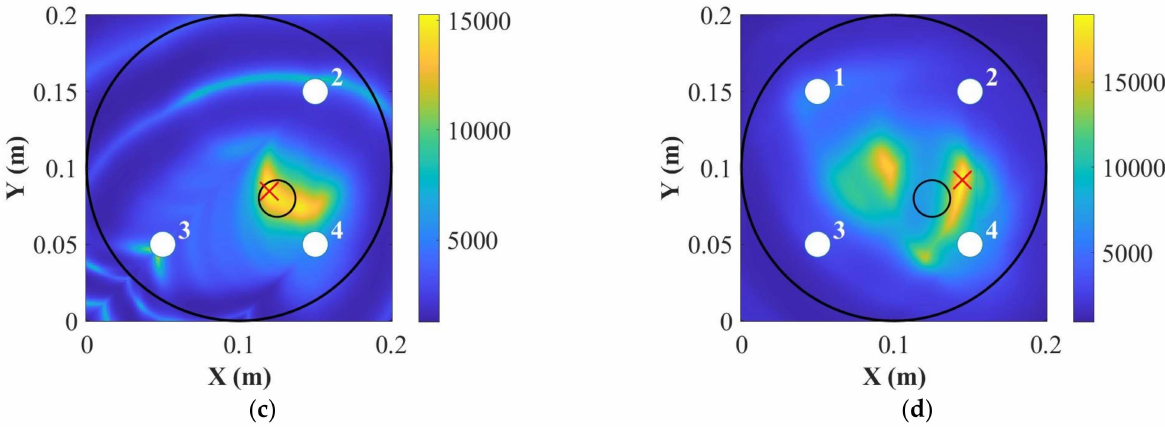
Figure 10. Detection of surface-mounted artificial damage on the bottom of the host structure using ( a ) three PZT transducers and ( b ) four PZT transducers, and localization using ( c ) three PZT transducers and ( d ) four PZT transducers at 250 kHz for the position 2 (where the “ for real damage and the “ × ” is the position for predicted